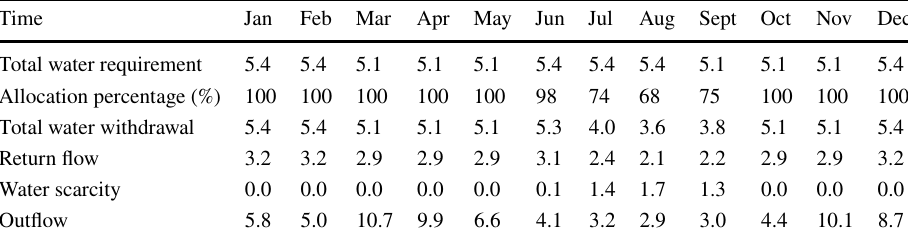
Table 1 The results of the coupled model based on the baseline scenario (dam 3 )